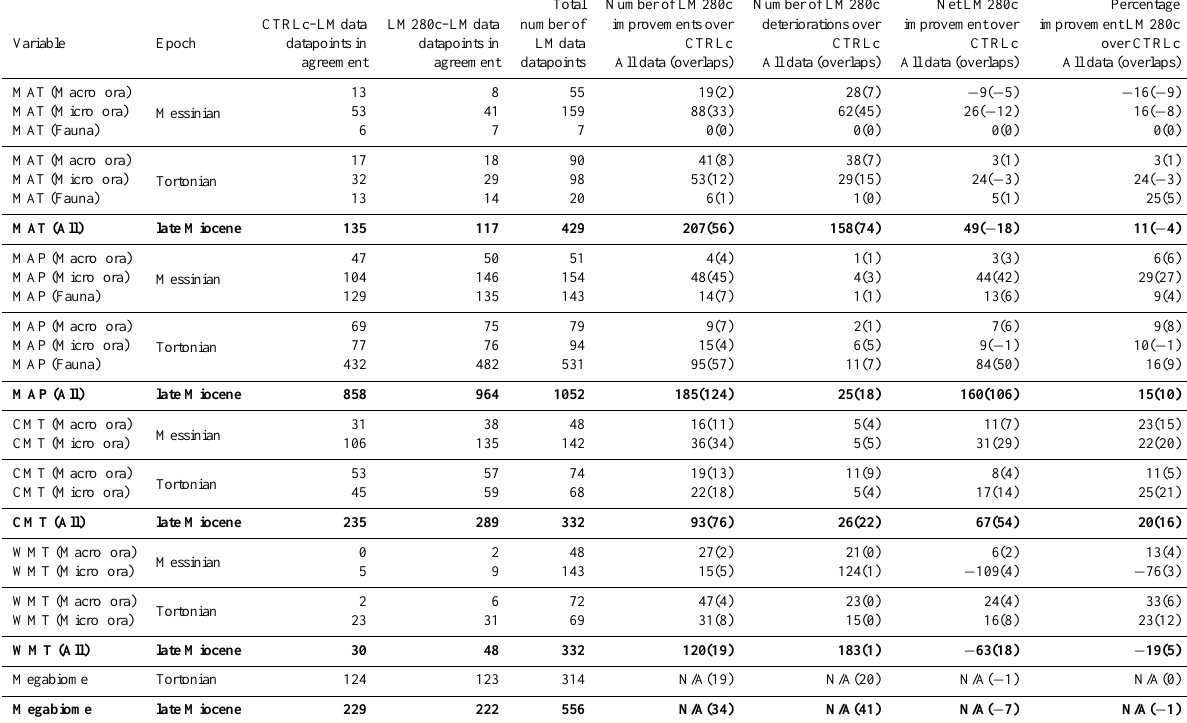
Table 2. Results from the model–data comparison for modern and late Miocene palaeogeography. Totals are expressed in bold.